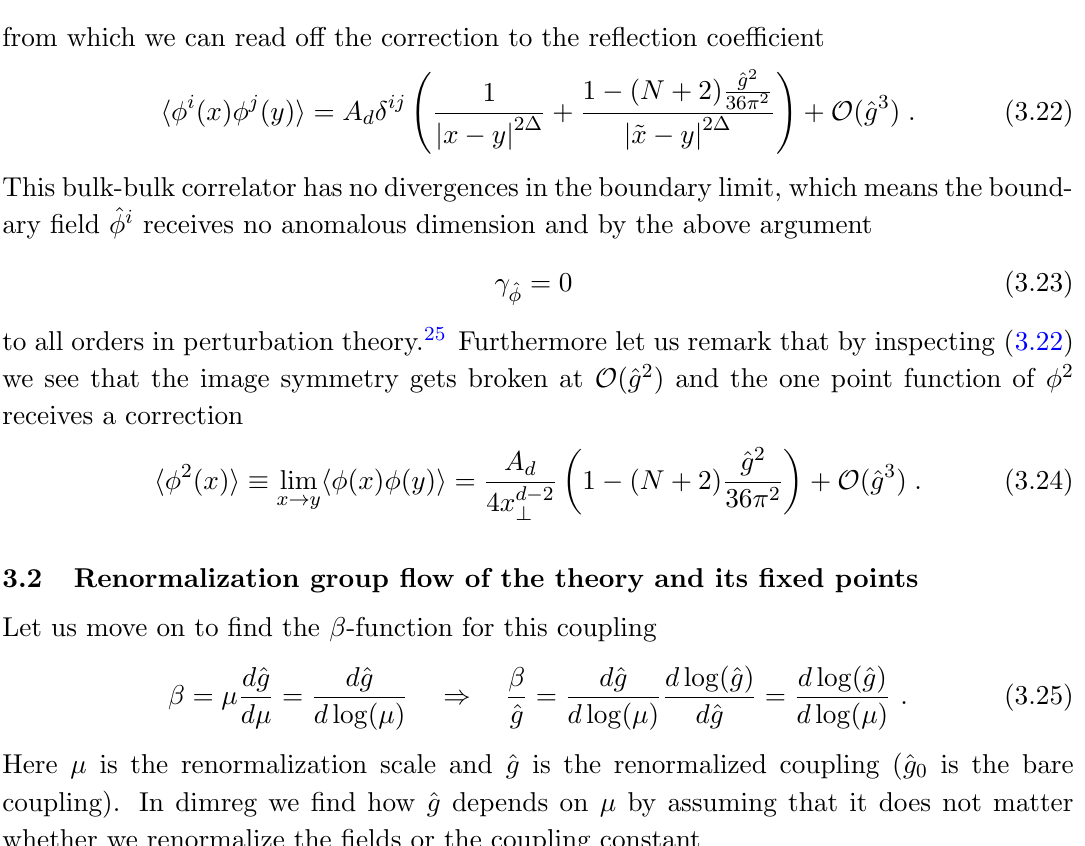
Figure 1 . The (cid:30) (cid:0) (cid:30) correlator at order ^ g 2